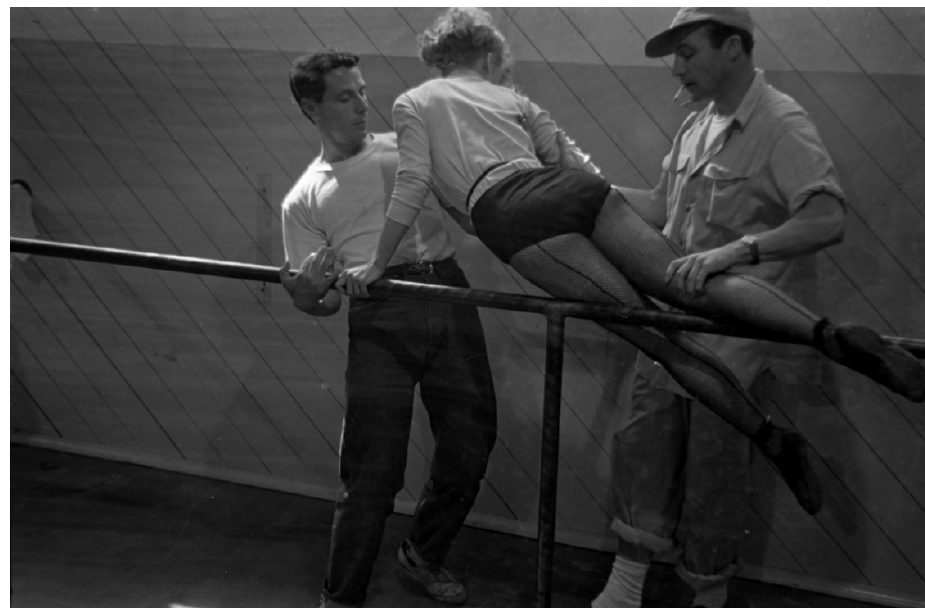
Figure 1. Alex Romero, Vera ‐ Ellen, and Gene Kelly rehearsing “A Day in New York” from On the Town on the MGM lot. Jon Brenneis photograph archive, BANC PIC 2002.171, The Bancroft Library, University of California, Berkeley. Brenneis took the photograph while employed by LIFE Magazine in July 1949. [Jon Brenneis]/[The LIFE Images Collection] via Getty Images.